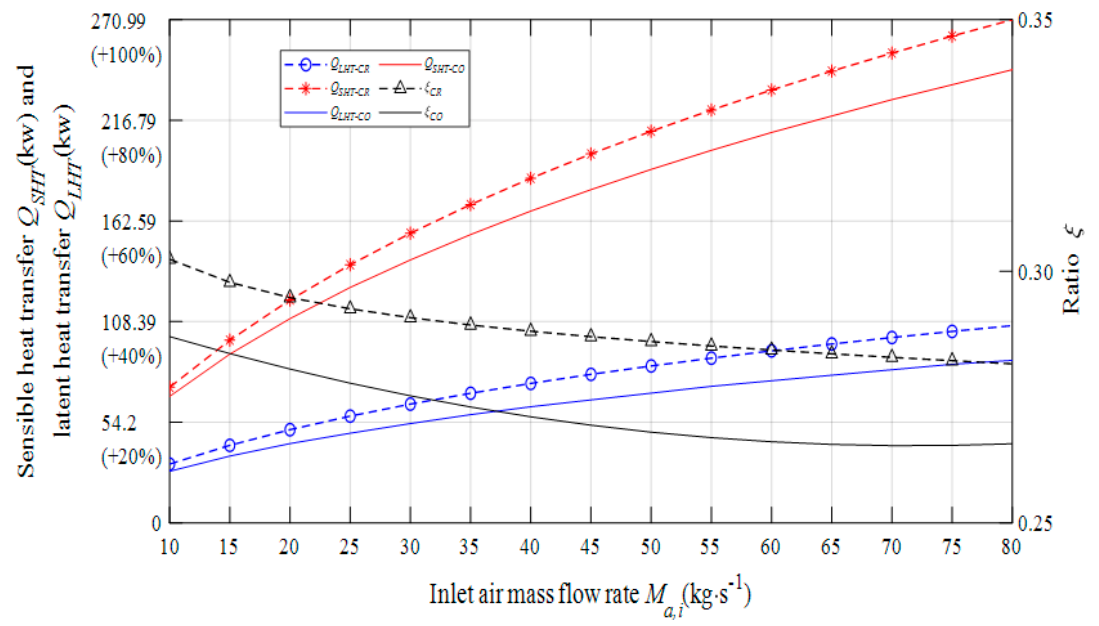
Figure 14. Influence of air inlet mass flow rate on energy transfer characteristics.